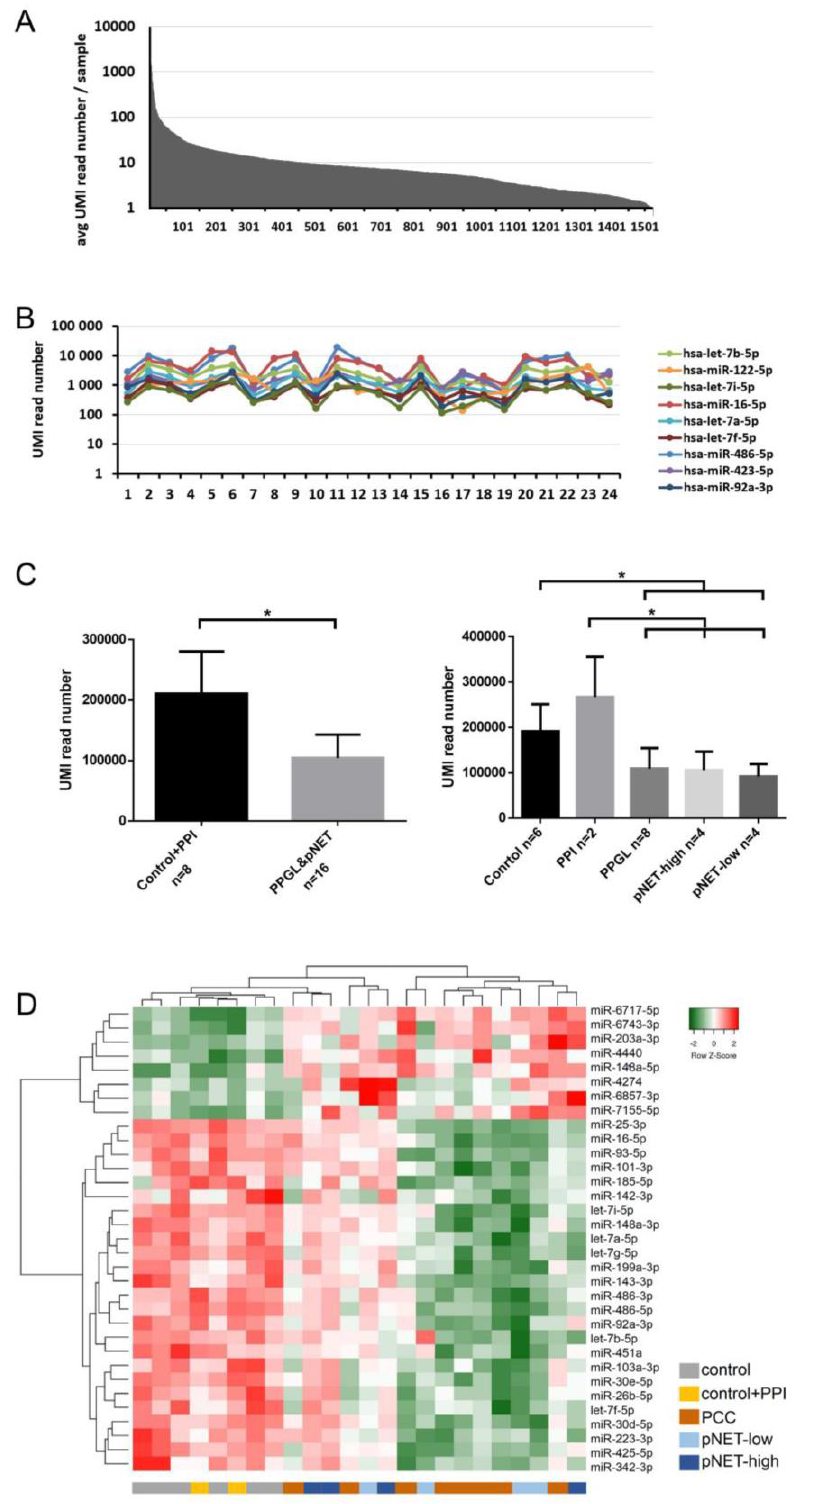
Figure 1. MiRNA expression in the exploratory study. ( A ) MiRNA abundance in serum. ( B ) Expression of the 9 most abundant miRNAs. ( C ) Global miRNA expression level among normal controls and pNET / PCC samples. Error bars indicate mean ± SE. * represents p -value < 0.05. ( D ) 33 di ff erentially expressed miRNAs among di ff erent groups can discriminate against control and pNET / PCC samples. Green indicates lower, red indicates higher expression.